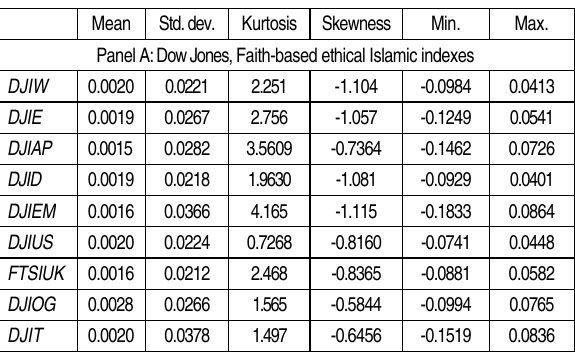
Table 4. Descriptive statistics of ethical & conventional DJ indexes